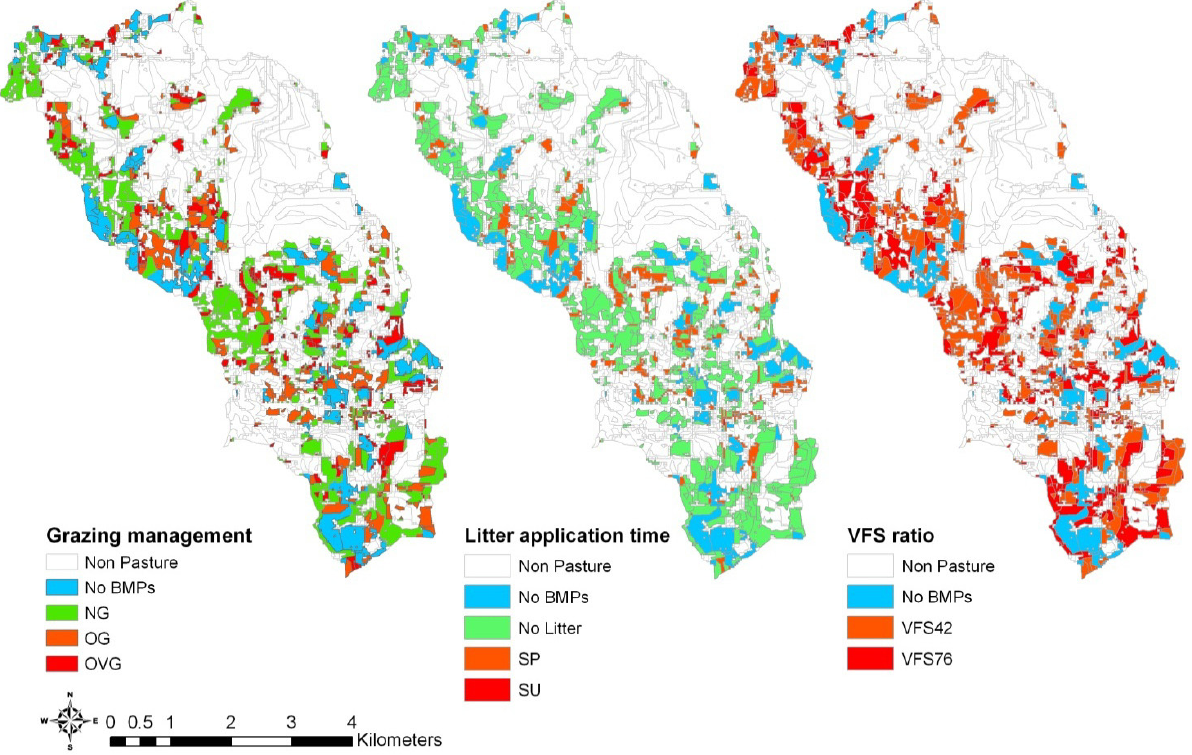
Figure 7. Distribution of BMPs selected by the optimization model with the 171 BMP options on 77% of the pasture lands in the watershed.